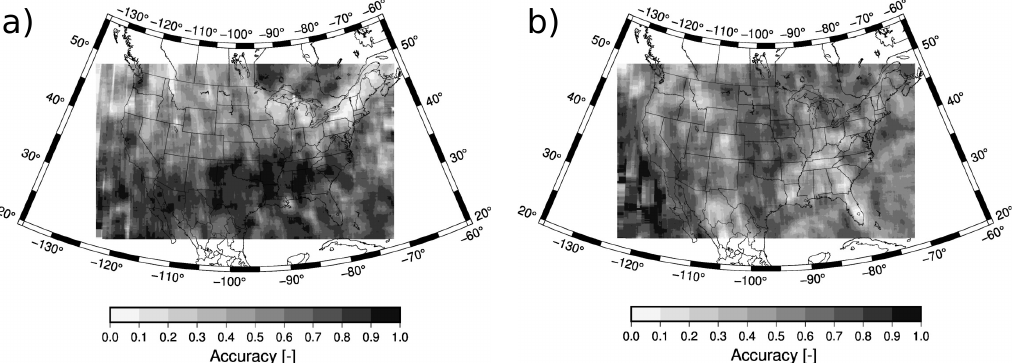
Figure 9. Accuracy for the daytime clear sky retrievals during ( a ) Winter and ( b ) Summer. The values are calculated using data within 15 by 15 grid